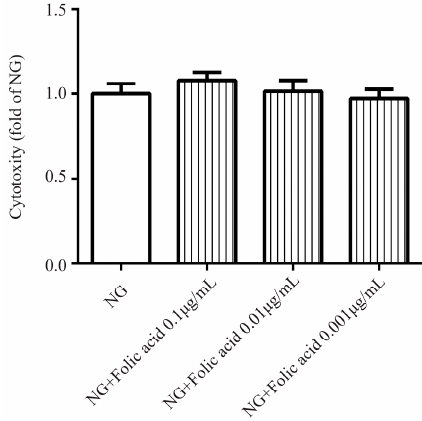
Figure 1. Folic acid had no toxic effect on RVECs. The cells (4000 per/well) were treated with NG or various concentrations of folic acid for 72 h. The abbreviation NG represents normal glucose, i.e., the cells were cultured in a medium with a glucose concentration at 5.5 mM. The effect of folic acid (0.1–0.001 µ g/mL) on RVECs cytotoxicity was assessed by CCK-8 assay. The data was presented as means ± SD ( n = 6).